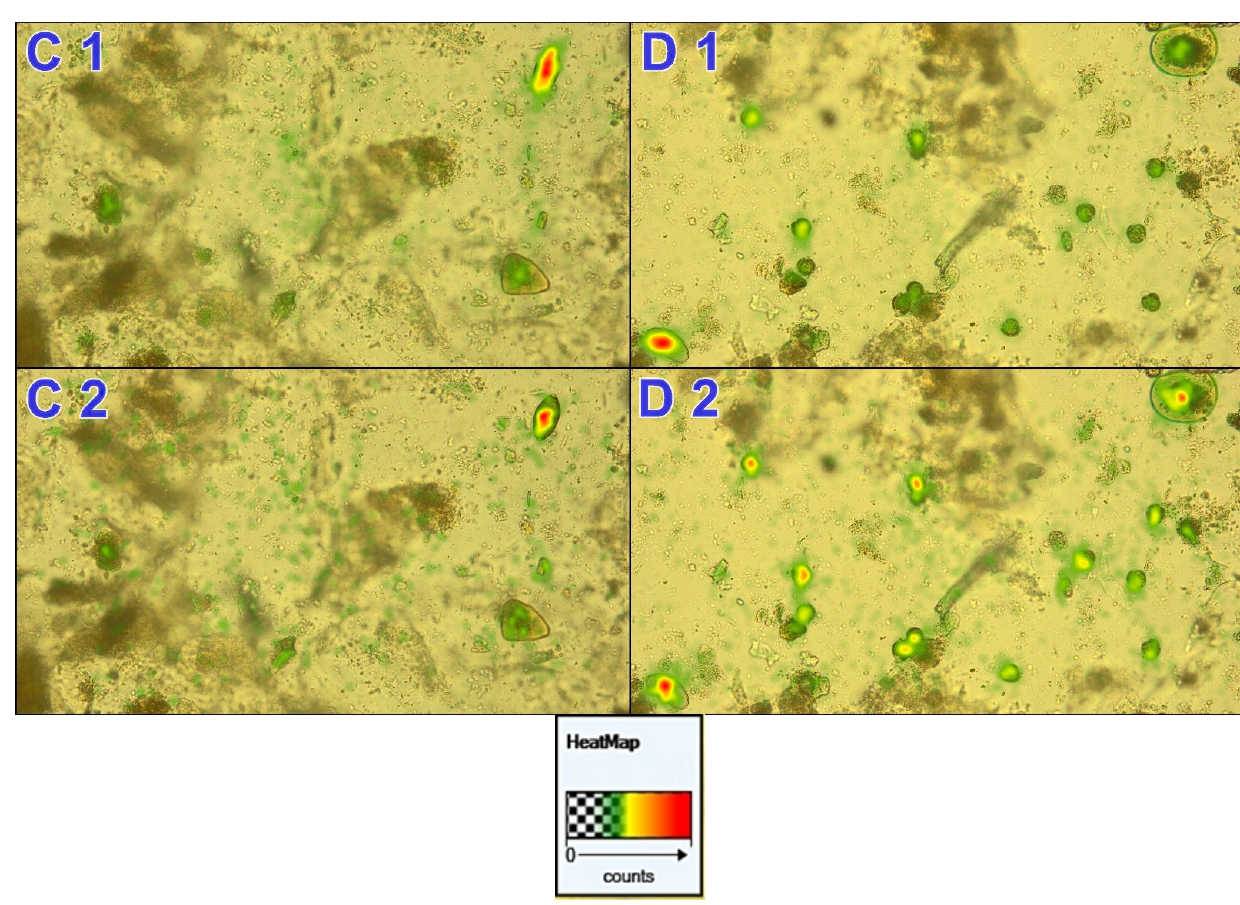
Figure 4. Example heatmap based on the analysis of preparation C, Trichuris trichiura , and D, Enterobius vermicularis (1, correct diagnosis of all participants, 2, incorrect diagnosis of all participants). A heatmap is a type of information showing the number of gazes (fixations), i.e. how many times the respondents looked at a given area.